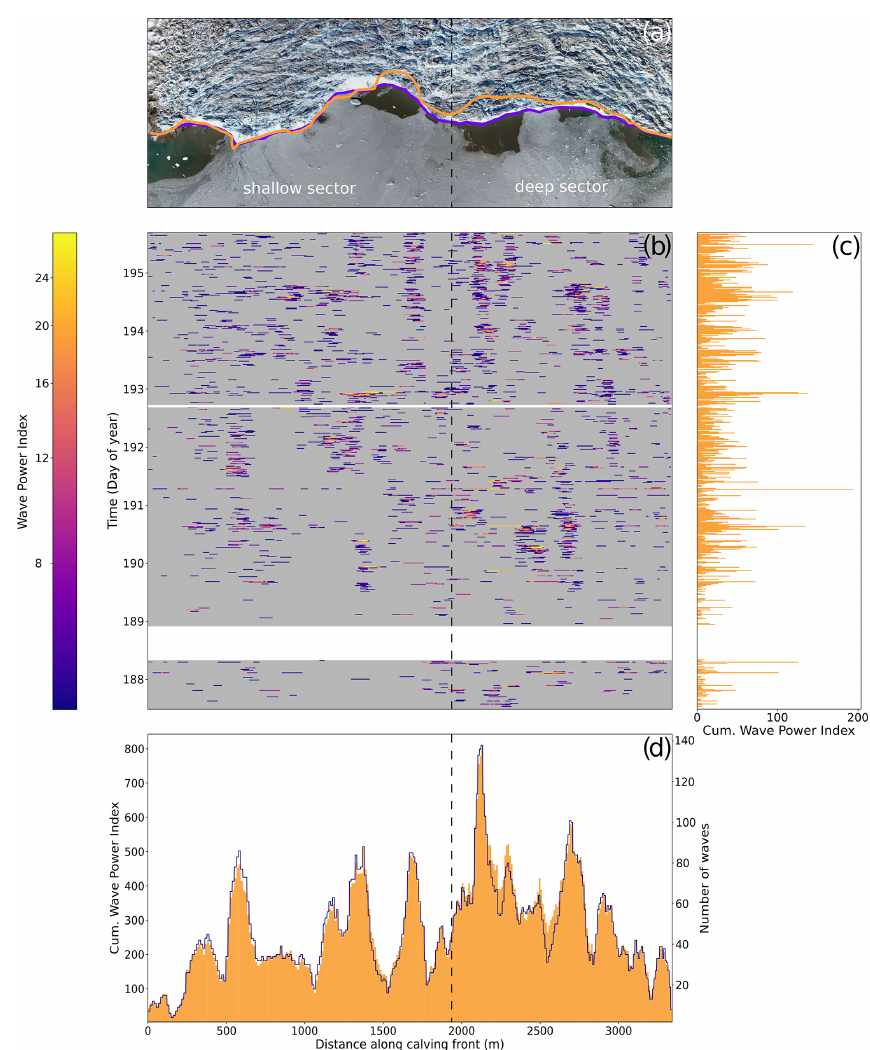
Figure 5. Results of the automatic wave detection by TeRACWA during the 2018 field season. (a) Orthomosaic of the calving front acquired on 6 July using an unmanned aerial vehicle (Jouvet et al., 2019) combined with the outline of the calving front at the beginning (6 July; purple curve) and end (14 July; orange curve) of the TRI observation period (Walter et al., 2021). The vertical dashed line indicates the transition from the shallow sector to the deep sector. (b) Wave power index (WPI) of the waves detected over time (20min stacks) along the calving front. White areas correspond to data gaps. (c) Spatially cumulated WPI over time with WPI values from (b) summed along the front. (d) Temporally cumulated WPI (orange bars) and number of waves (purple line) along the calving front, over the entire